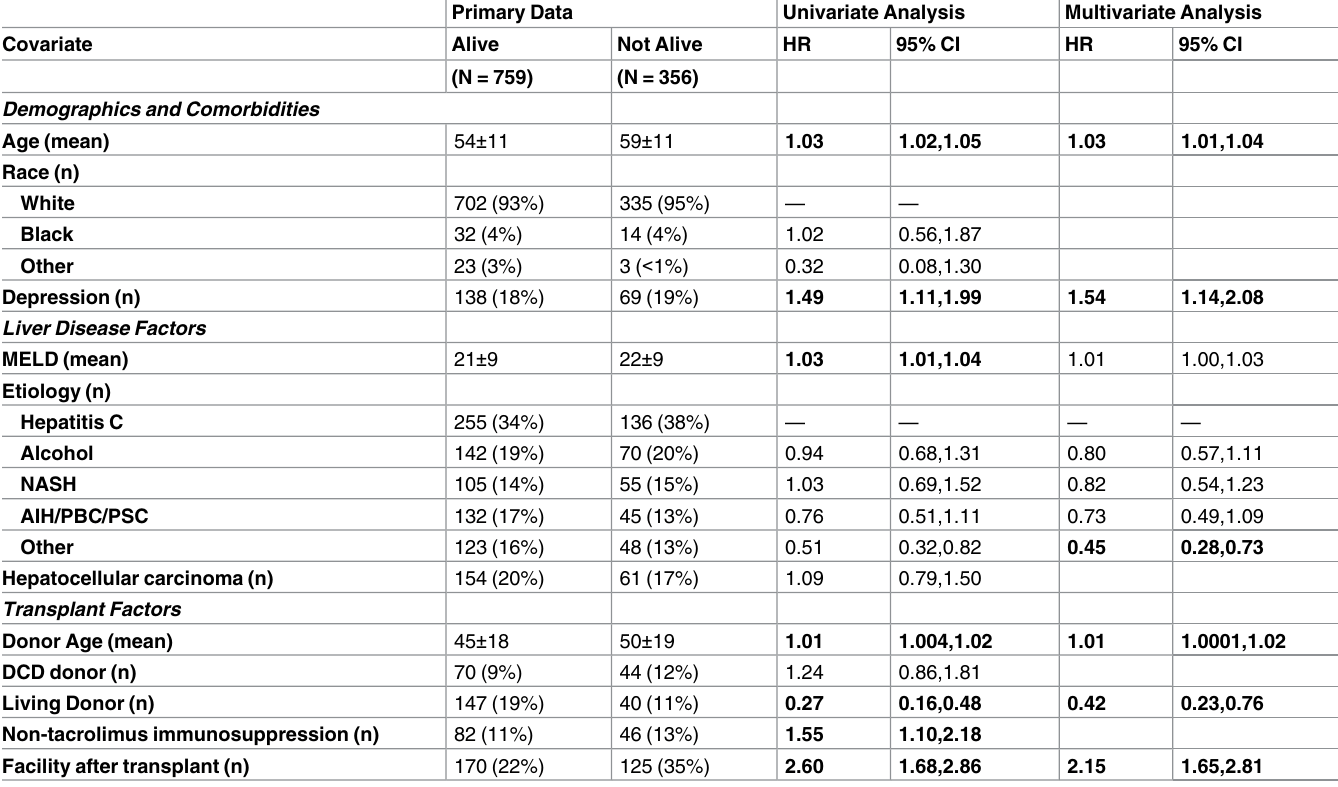
Table 3. Post-Transplant Survival: Primary Data and Cox Proportional-Hazards Models.